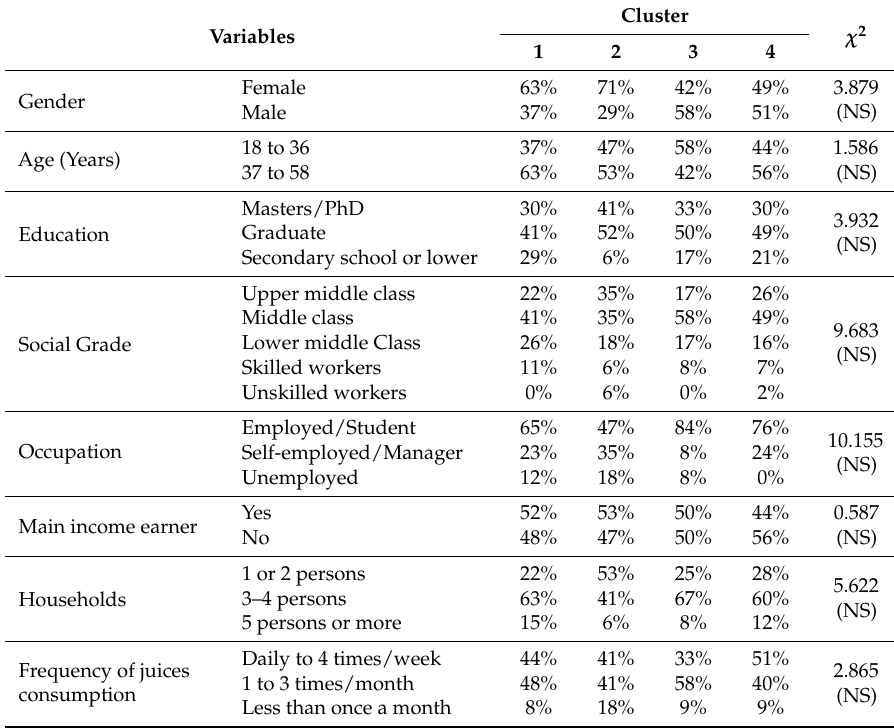
NS—non ‐ significant.